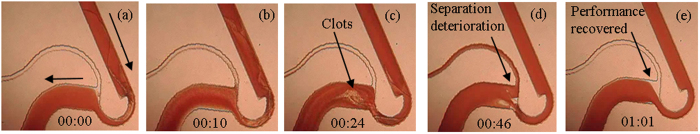
Demonstration of clog-free operation. Images taken at time (a) 0, (b) 10, (c) 24, (d) 46 and (e) 61 seconds. Notice that the cell aggregates are cleared in less than a minute of operation. The presence of aggregate in the microchannel alters the flow behavior (see Fig. 7 b–d). This results in flowing of large number of cells in the plasma channel, and there is a decrease in the separation efficiency during this time period.